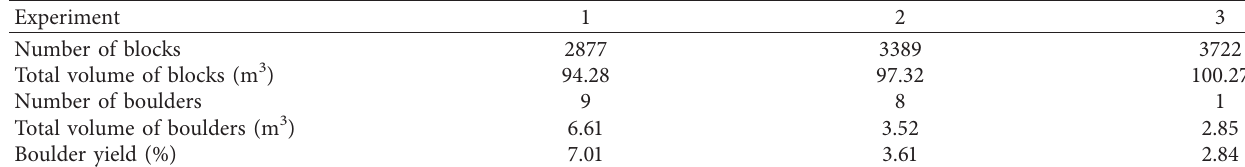
Table 10: Bench rock crushing situation.